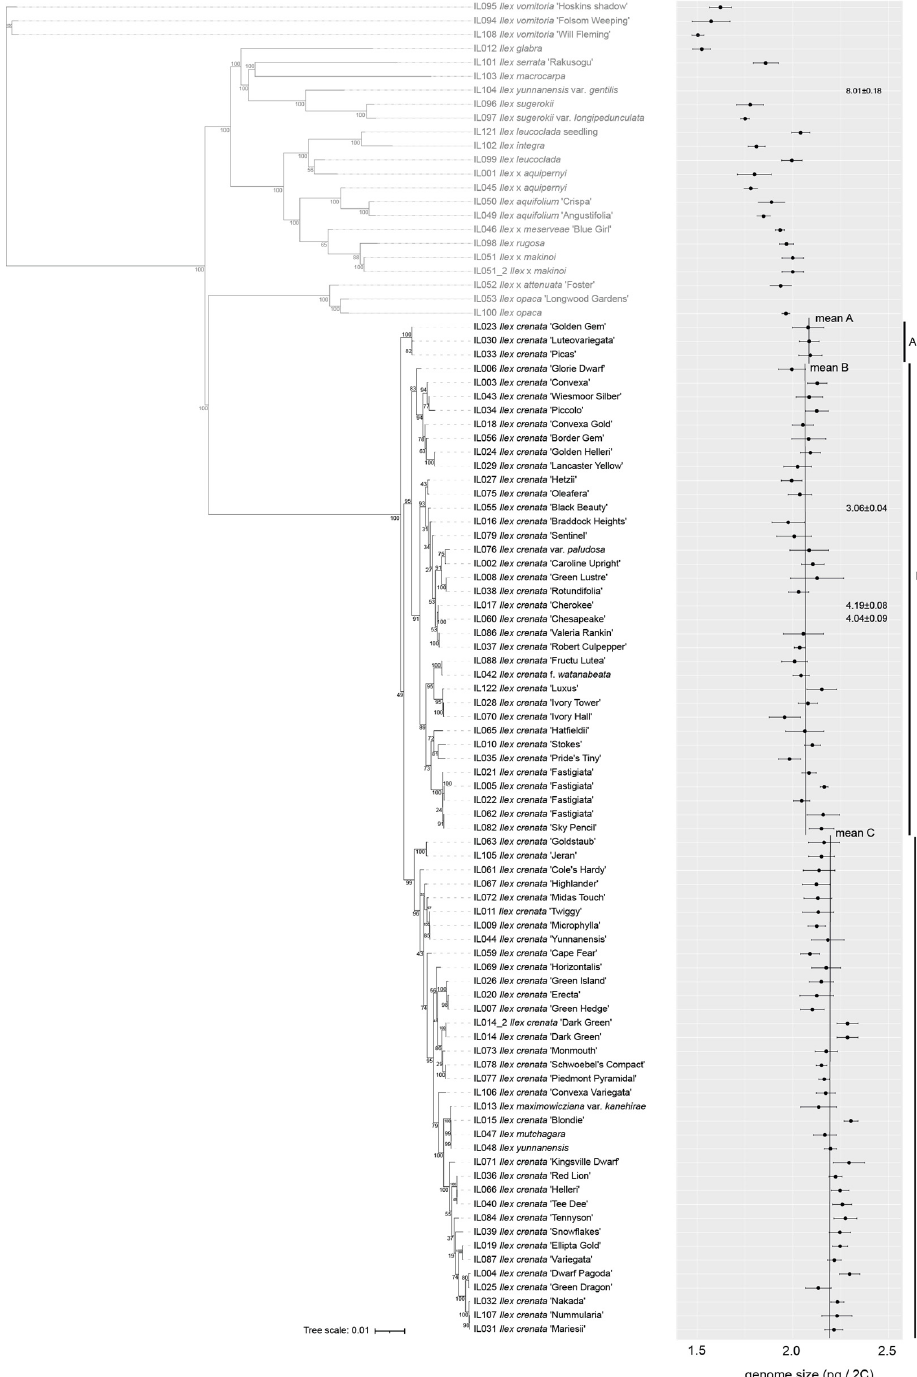
Figure 1. Phylogenetic tree of the Ilex collection along with the genome size (pg/2C-value). The clades containing non- Ilex crenata spp. are depicted in grey and the clades containing I. crenata ac- cessions in black. The three clades within I. crenata are indicated on the right (Clade A, Clade B, and Clade C). For every genotype a dot represents the mean genome size ( n = 6) and the horizontal bar the standard deviation, as measured using flow cytometry. Vertical lines labeled mean A, mean B, and mean C indicate the mean genome sizes per clade (polyploids not included) of 2.09 ± 0.006; 2.07 ± 0.05, and 2.19 ± 0.06 pg/2C ± sd for clade A, B, and C, respectively. The genome size of genotypes with a genome size exceeding the scale are depicted on the right.